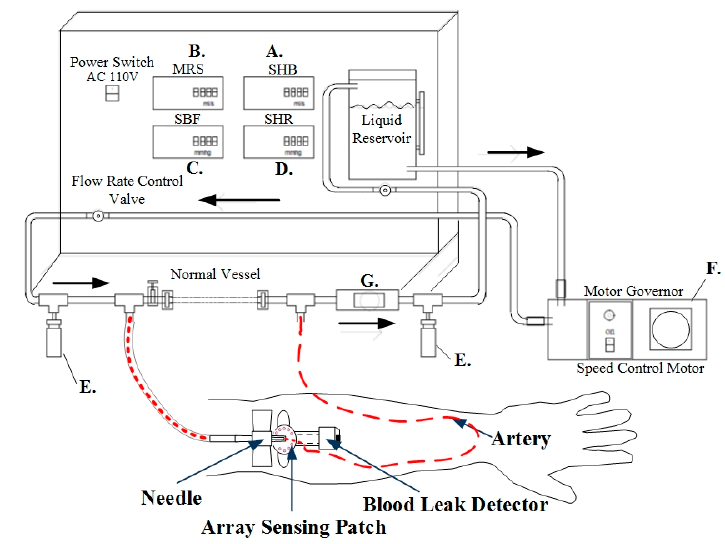
Figure 7 . Design of blood circulation simulation system.